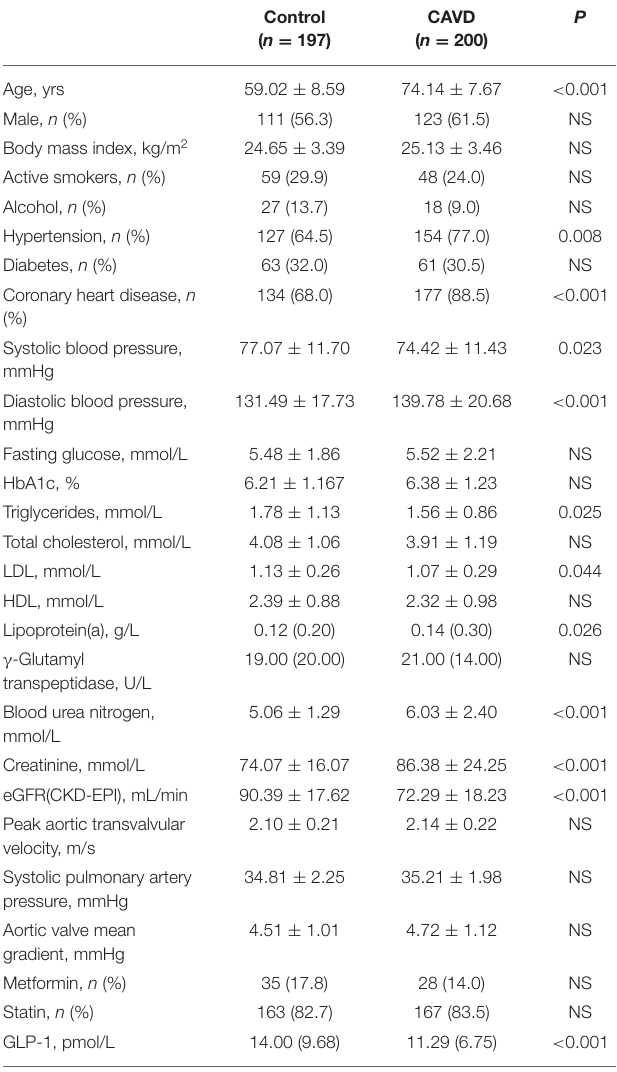
7 to 21 days. Alizarin Red S staining showed that the extent TABLE 2 | Clinical characteristics of the control and CAVD groups. of calcification rapidly and significantly increased with the time Control CAVD extension (7 days = 129.0 ± 9.2 µ g/mg, 14 days = 161.0 ± 6.4 ( n = 197) ( n = 200) µ g/mg, and 21 days = 218.5 ± 7.6 µ g/mg compared with 7 days: P < 0.01); however, GLP-1 significantly weakened this tendency (respectively, 79.0 ± 7.1, 91.3 ± 10.8, and 108.3 ± 10.5 µ g/mg compared with the same groups without GLP-1 treatment: P